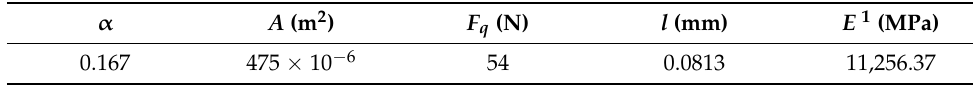
Table 1. Parameters used for the adjusted Iwan model.